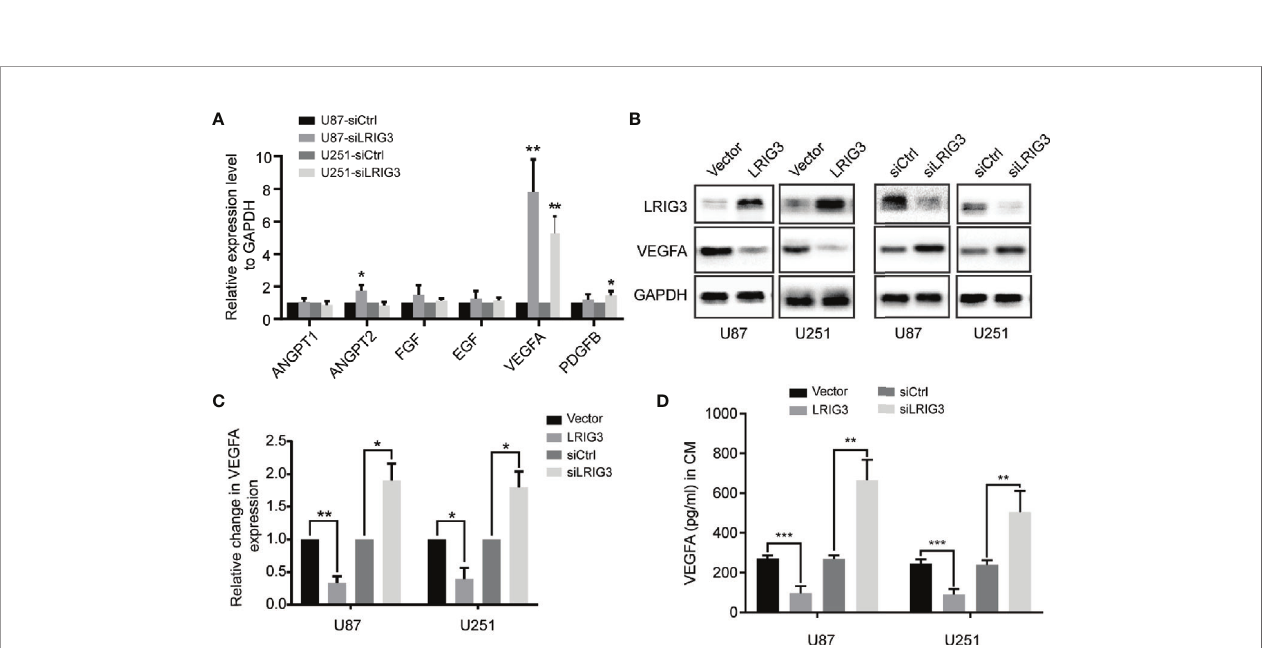
FIGURE 4 | LRIG3 inhibited glioma angiogenesis by regulating VEGFA expression. (A) qRT-PCR analysis targeting angiogenic factors in glioma cells transduced with LRIG3 and control siRNAs. (B) Western blot analysis of VEGFA, LRIG3, and GAPDH. (C) Integrated density of the bands was normalized to GAPDH in LRIG3 knockdown or overexpression glioma cells. (D) Levels of VEGFA protein in the CM from glioma cells with LRIG3 knockdown or overexpression were detected by ELISA. Data are means ± SD of 3 independent replicates. * p < 0.05; ** p < 0.01; *** p < 0.001. CM, conditioned